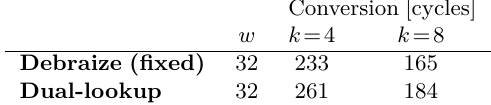
Table 4: Performance numbers for 16-bit A2B conversion with countermeasures for microarchitectural